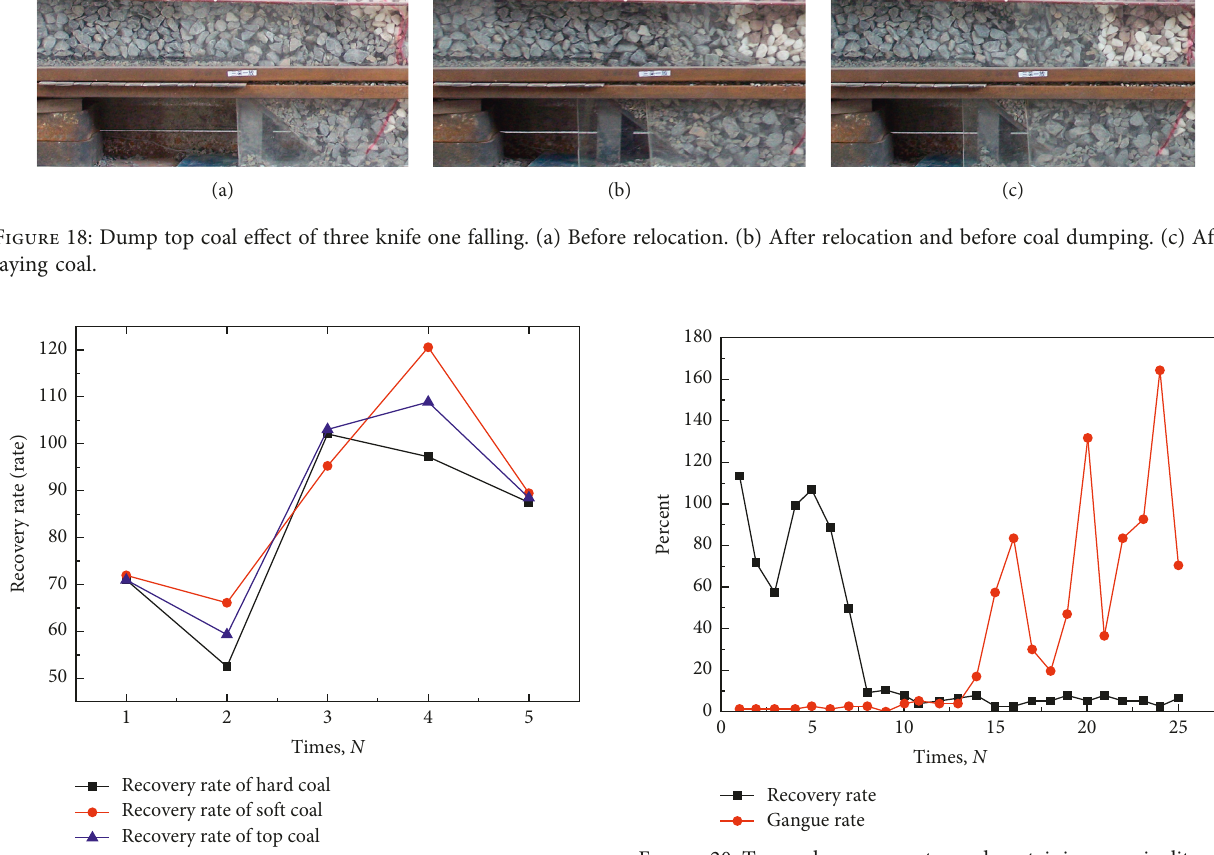
Figure 19: Recovery rates of three knife one falling.